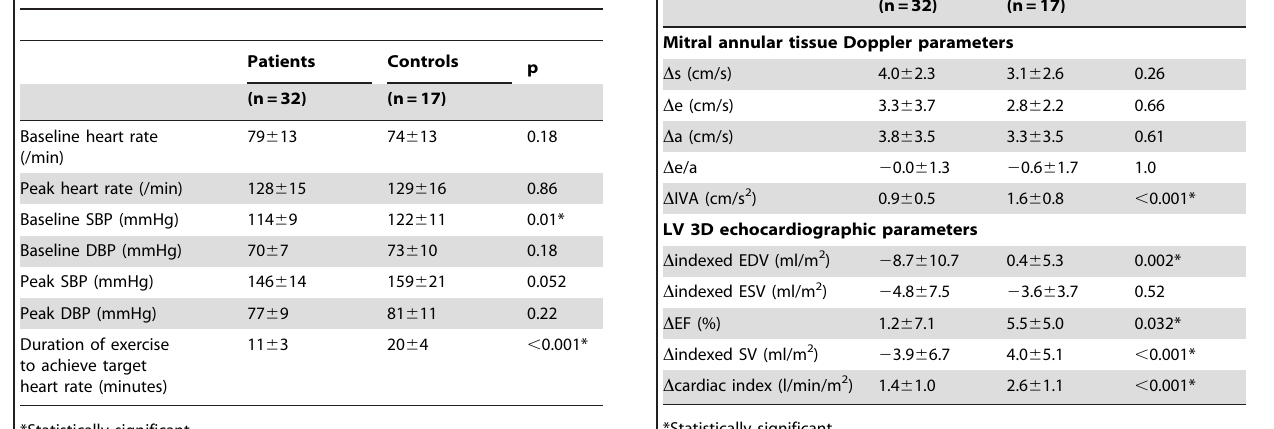
Table 3. Exercise testing parameters.